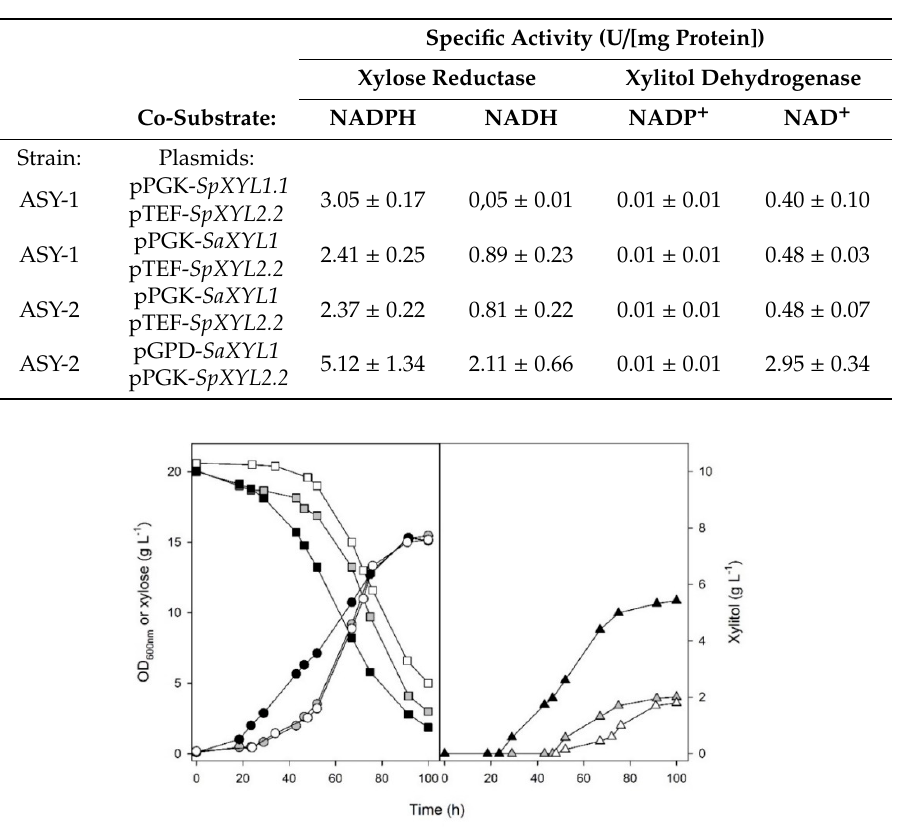
Figure 1. Time course of aerobic cell growth (OD 600nm , circles), xylose consumption (squares), and xylitol production (triangles) in synthetic complete (YNB) medium containing 2% xylose by yeast cells of strain ASY-1 transformed with plasmids pPGK- SpXYL1.1 and pTEF- SpXYL2.2 (white symbols), or pPGK- SaXYL1 and pTEF- SpXYL2.2 (gray symbols), or strain ASY-2 (black symbols) transformed with the same two plasmids (pPGK- SaXYL1 and pTEF- SpXYL2.2 ).